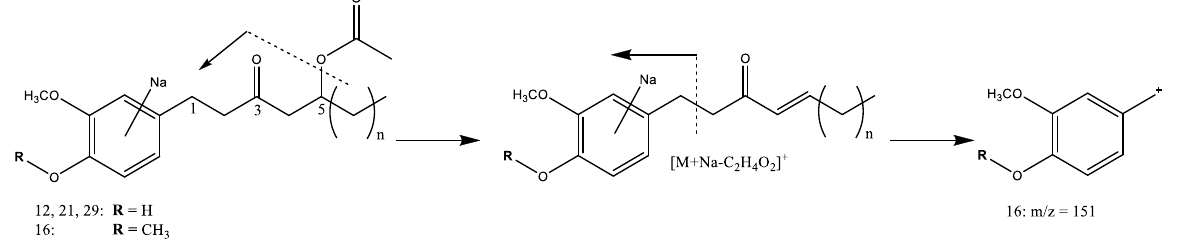
Figure 8. Fragmentation pathway for acetoxygingerol compounds 12 ( n = 6), 21 ( n = 8), 29 ( n = 10) and methylacetoxygingerol 16 ( n = 6).